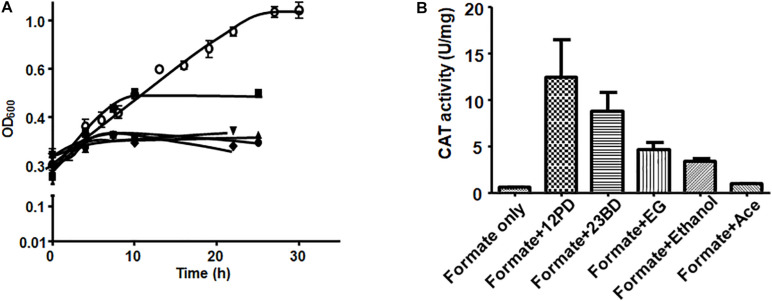
Substrate-dependence of pdu promoter activity. (A) Growth of A. woodii harboring plasmid pMTL82254-PpduA on addition of respective substrate after growth on 100 mM formate (•), 15 mM 1,2-PD (■), 20 mM 2,3-BD (▲), 50 mM ethylene gycol (▼), 5 mM acetaldehyde (◆), 50 mM ethanol (○). Time zero correspond to late exponential growth phase on 100 mM formate where induction was done. (B) CAT activity of A. woodii harboring plasmid pMTL82254-PpduA, induced by different substrates. Formate only, corresponds to the culture without inducing substrate added.